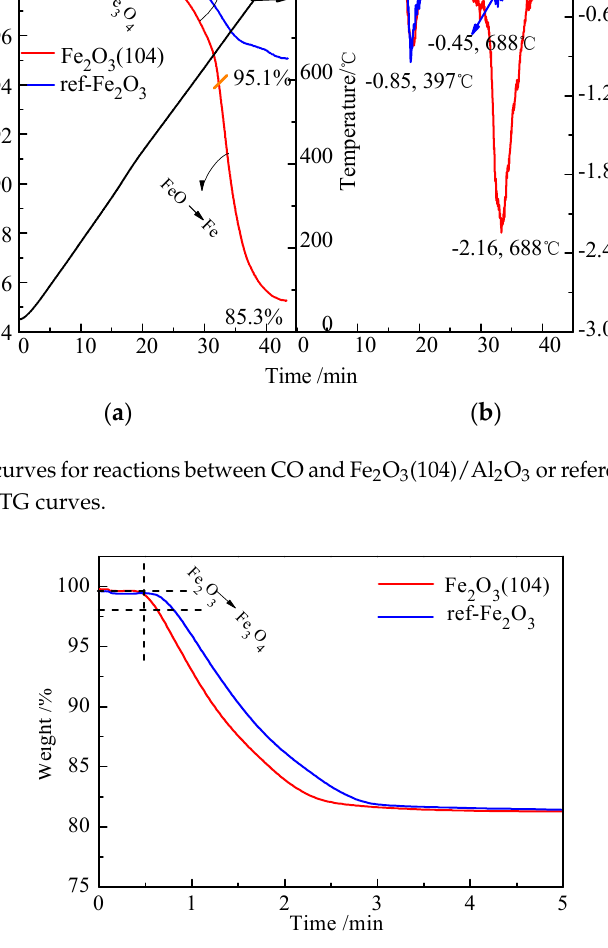
Figure 5. Isotherm thermogravimetric analyzer (TGA) experiments between CO and Fe 2 O 3 (104)/Al 2 O 3 or referenced Fe 2 O 3 /Al 2 O 3 at 800 °C.